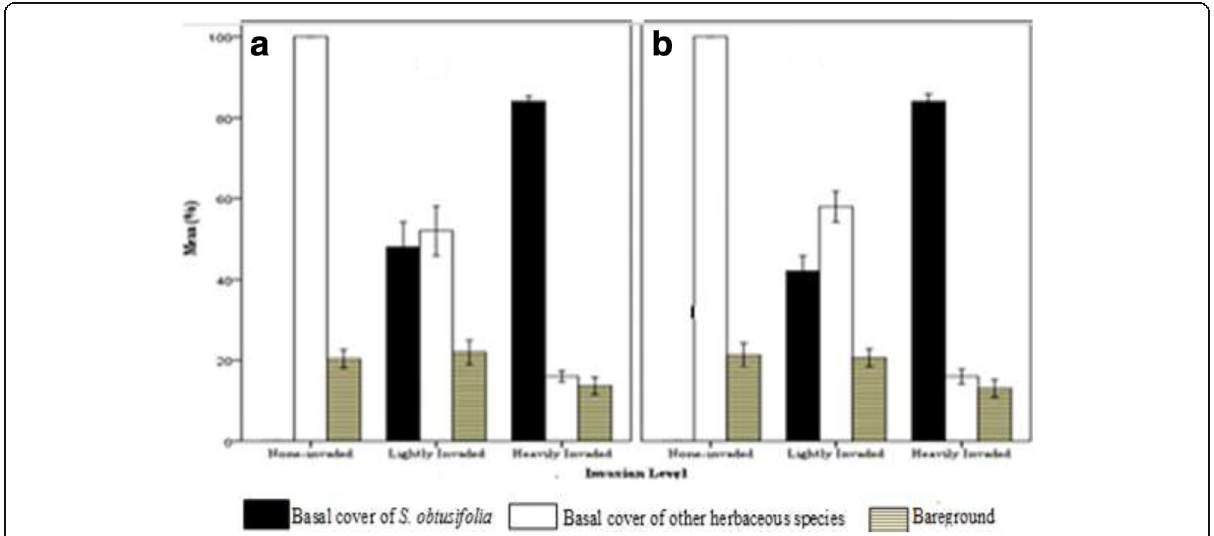
Fig. 5 Percentage of bare ground, basal cover of S. obtusifolia , and basal cover of other herbaceous species under three invasion levels (non-invaded, lightly invaded, and heavily invaded) at Kafta Humera ( a ) and Tsegede ( b ) district in the western Tigray region, northern